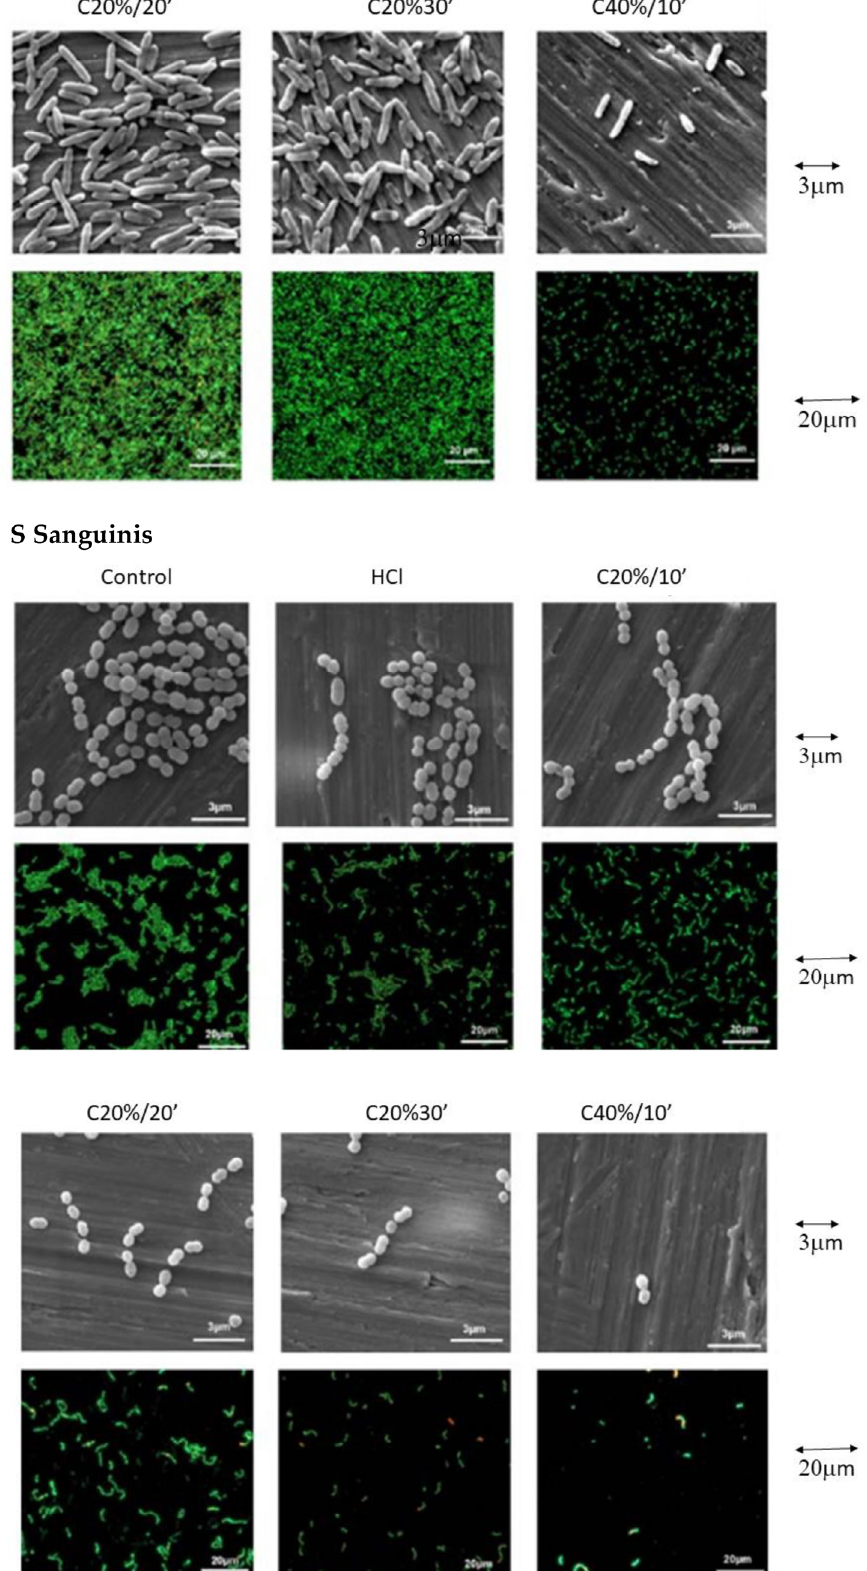
Figure 7. SEM and CLSM Microscope images of bacterial strains stained using Live/Dead ® BacLight bacterial viability kit which allows the assessment of the bacterial viability on each condition. Live = green and dead = dark red.